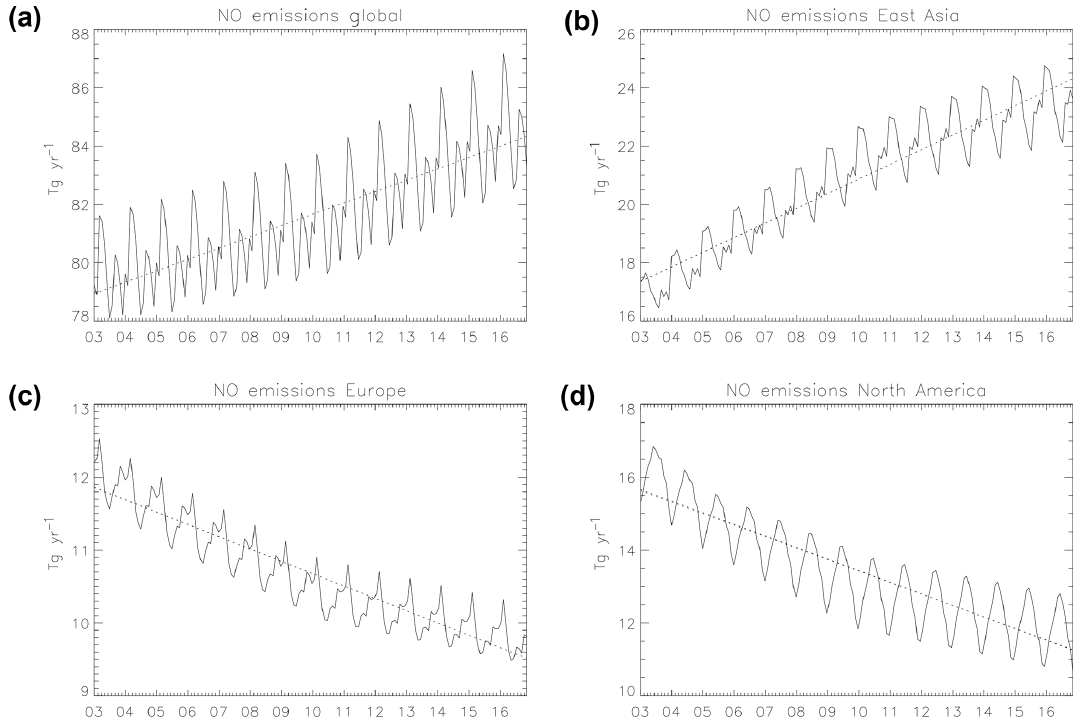
Figure 3. Monthly NO emissions in Tgyr − 1 from anthropogenic sources (MACCity) for (a) the globe, (b) East Asia, (c) Europe and (d) North America for the period 2003–2016.